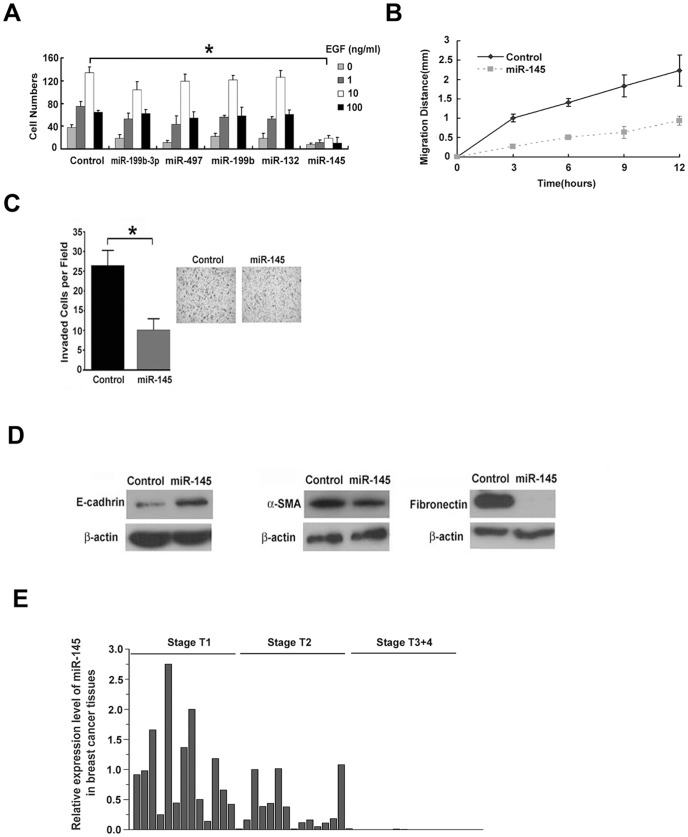
MiR-145 inhibits cancer cell migration and EMT (A) Expression of miR-145 mimics inhibited EGF-induced chemotaxis in MDA-MB-231 cells.Statistical analysis was performed by one-way ANOVA.*, P<0.01 versus control. Error bars indicating SD. (B) Expression of miR-145 mimics inhibited cell migration in a wound-healing assay. Statistical analysis was also performed by one-way ANOVA. (Points, mean of three independent experiments; bars, SD.) (C) Cell migration and invasion were inhibited upon treatment with miR-145 mimics. Statistical analysis was assessed by the two-tailed Student’s t test. Columns, mean of three independent experiments; bars, SD. (D) Expression of miR-145 mimics enhanced the expression of E-cadherin, and suppressed the expression of α–smooth muscle actin and Fibronectin. A representive data of there separate experiments is shown. (E) Expression of miR-145 was examined in breast tumor tissues from 41 patients.